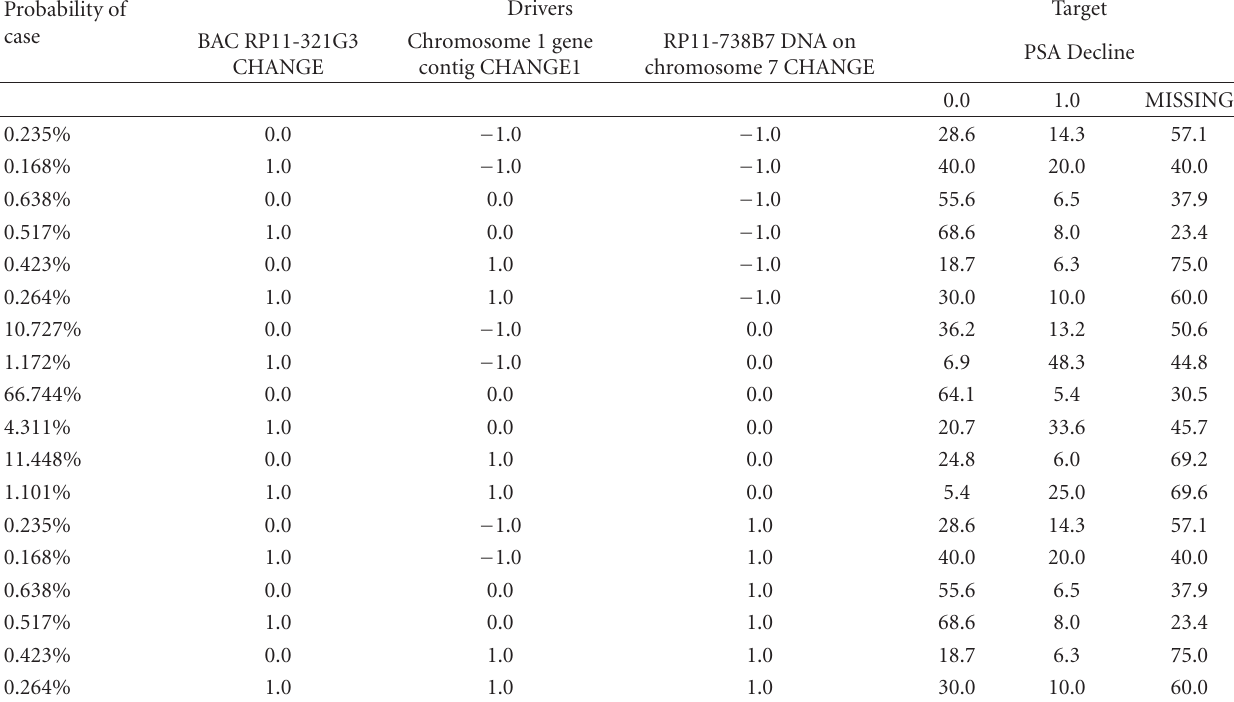
Table 2: Estimate of PSA decline given biomarker evidence. Inference table describing estimates of the posterior distribution of PSA decline (target) representing estimates of likelihood of increase (0), decrease (1), or unknown (MISSING). For example, the most common case involves no change in any of the independent features (biomarkers), occurs 66.7% and results in a 64.1% posterior probability of PSA increase. The case representing an increase in IgG responses to BAC RP11-321G3, a decrease in IgG response to chromosome 1 gene contig and no change in IgG response to RP11-738B7 DNA on chromosome 7 occurs 1.1% of the time and results in a 6.9% posterior estimate of PSA